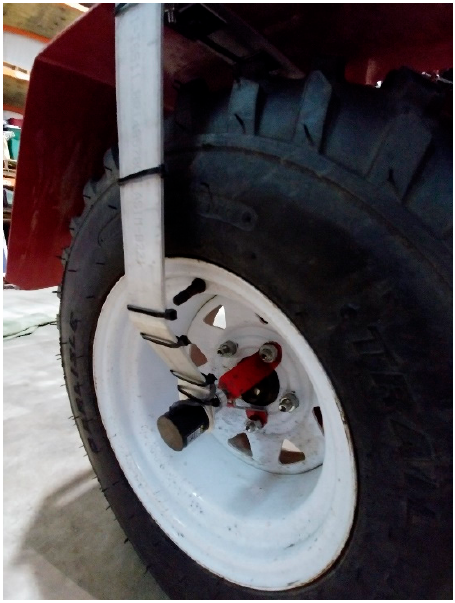
Figure 5. Encoder installed on the front tire of the rover to provide input pulses, which indicate how far the rover has moved. Table 1. Errors for five difference sensor configurations [23].